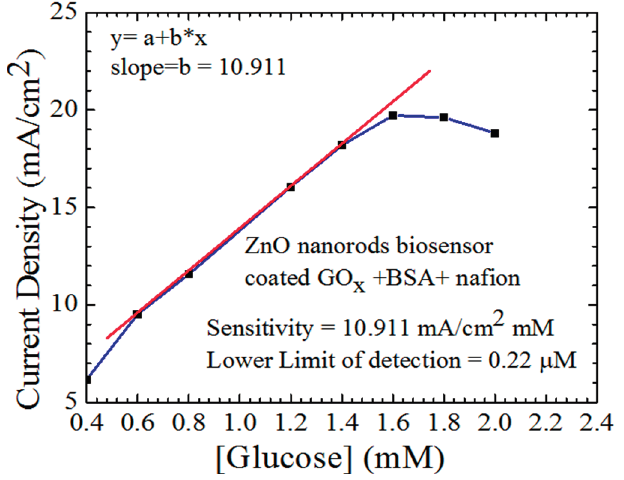
Figure 5. The sensitivity and the lower limit of detection of the fabricated ZnO nanorods electrochemical sensor were calculated from the linear line that starts from 0.6 to 1.4